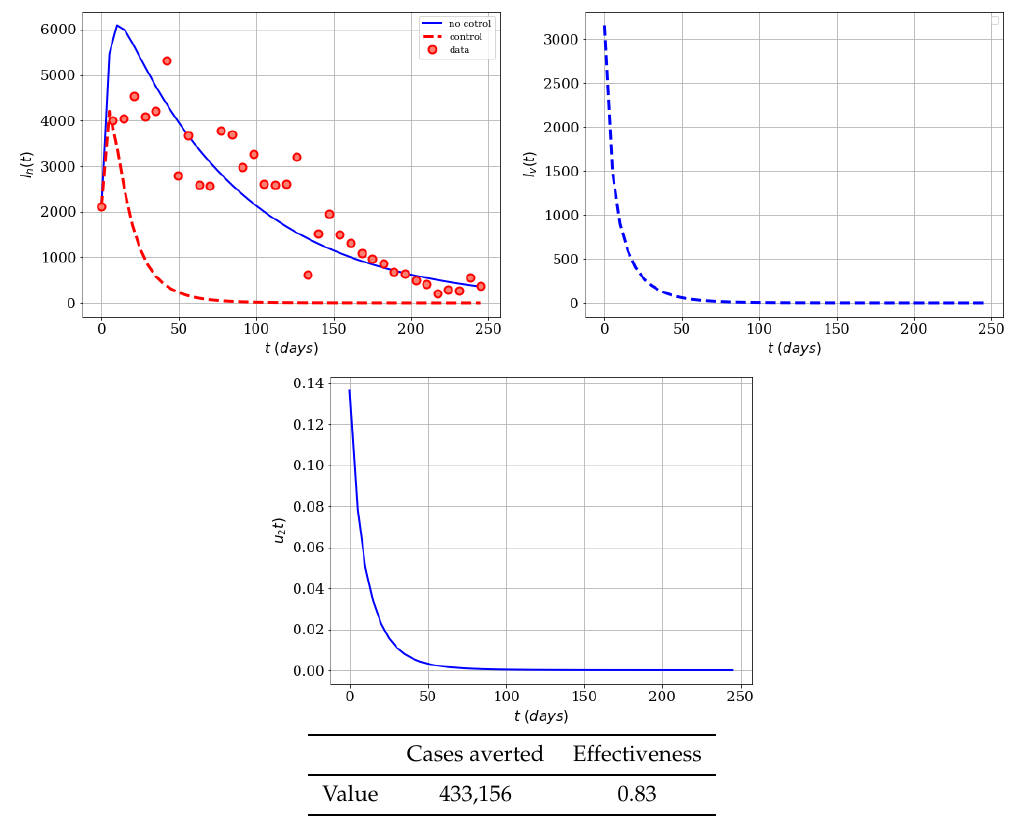
Figure 5. Numerical simulation of insecticide (spraying) campaign ( κ 1 = 0.1, u 2 max = 0.5) on the infected humans of the Zika mathematical model (1). Results regarding effectiveness are given in the table. The dots represent the real cases of infected people in Colombia for